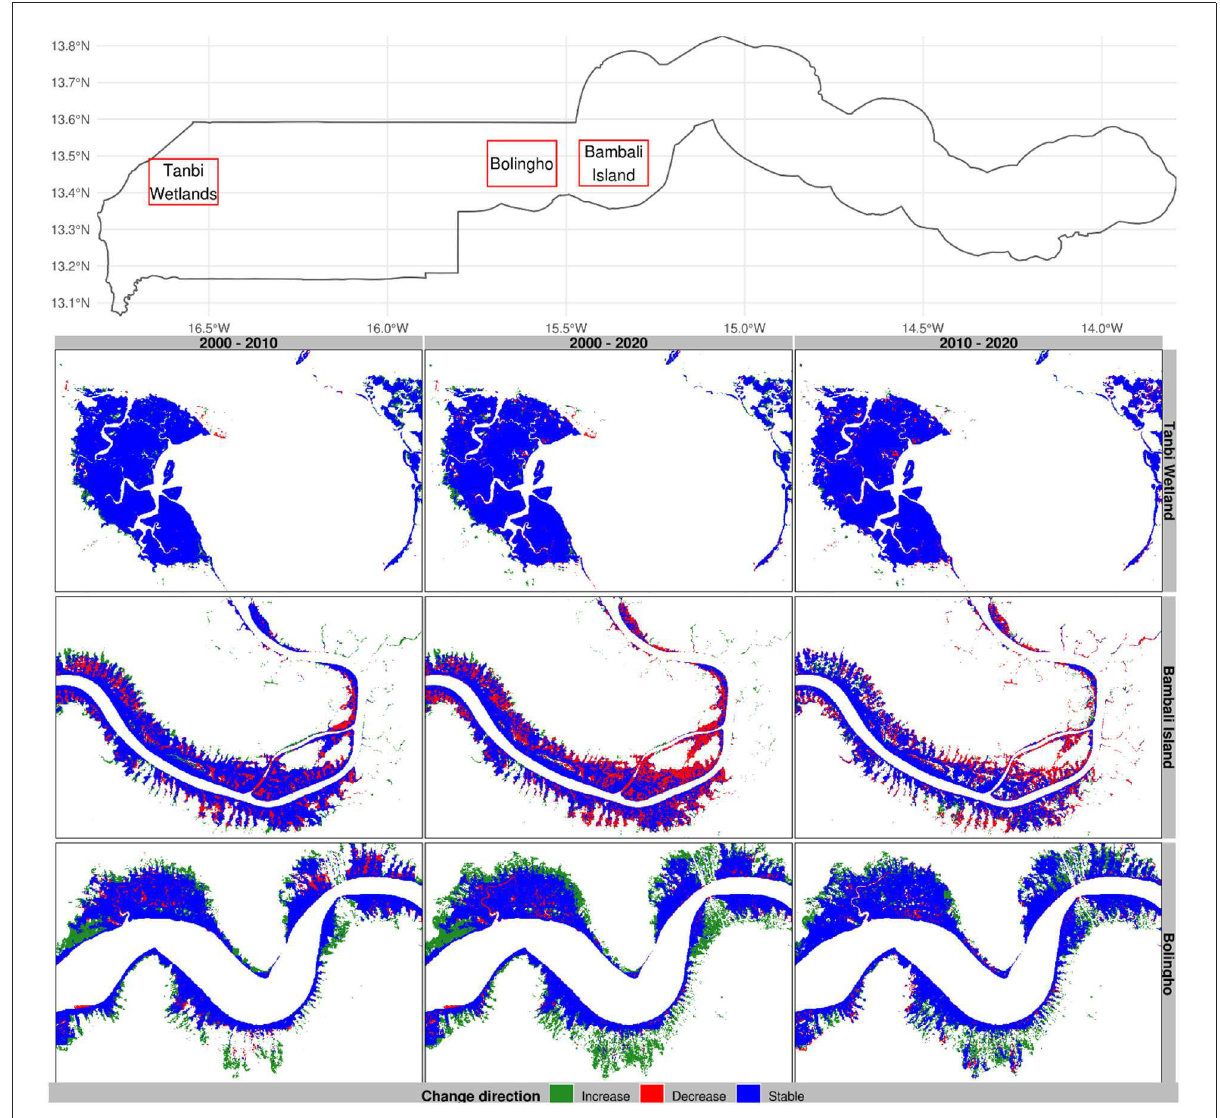
FIGURE6 Change direction in selected mangrove sites of The Gambia based on harmonic modeling and classification of Landsat and MODIS time series. These maps are snapshots of Tanbi Wetland Reserve, Bambali Island, and